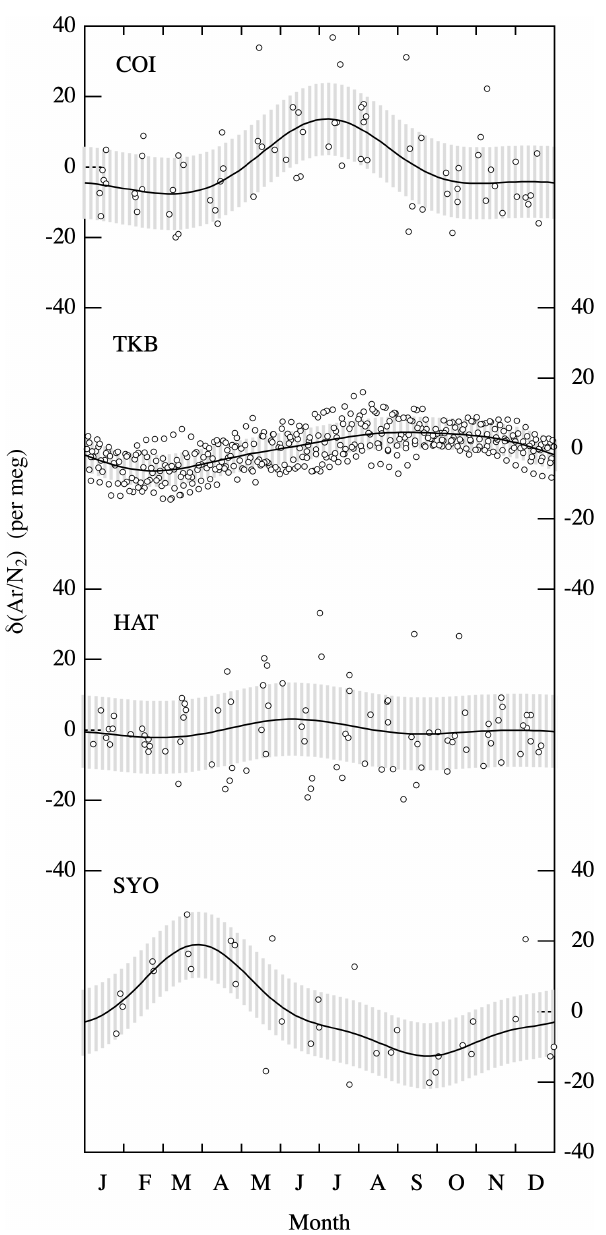
Figure 3. Detrended values of δ (Ar / N 2 ) (open circles) and average seasonal cycles of δ (Ar / N 2 ) (solid lines) observed at COI, TKB, HAT and SYO. Gray shaded areas denote standard deviations of the detrended values from the average seasonal cycle at each site.